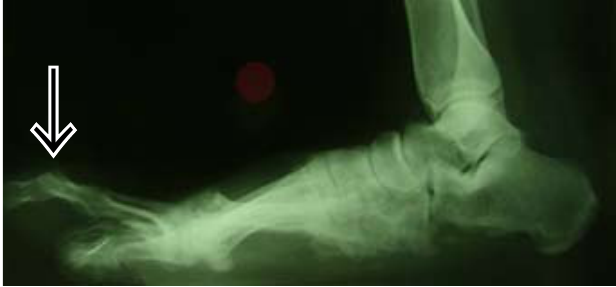
Fig. 15b. Frontal and lateral radiographs of the right foot showing macrodactyly (focal gigantism) of the 4th and 5th toes.